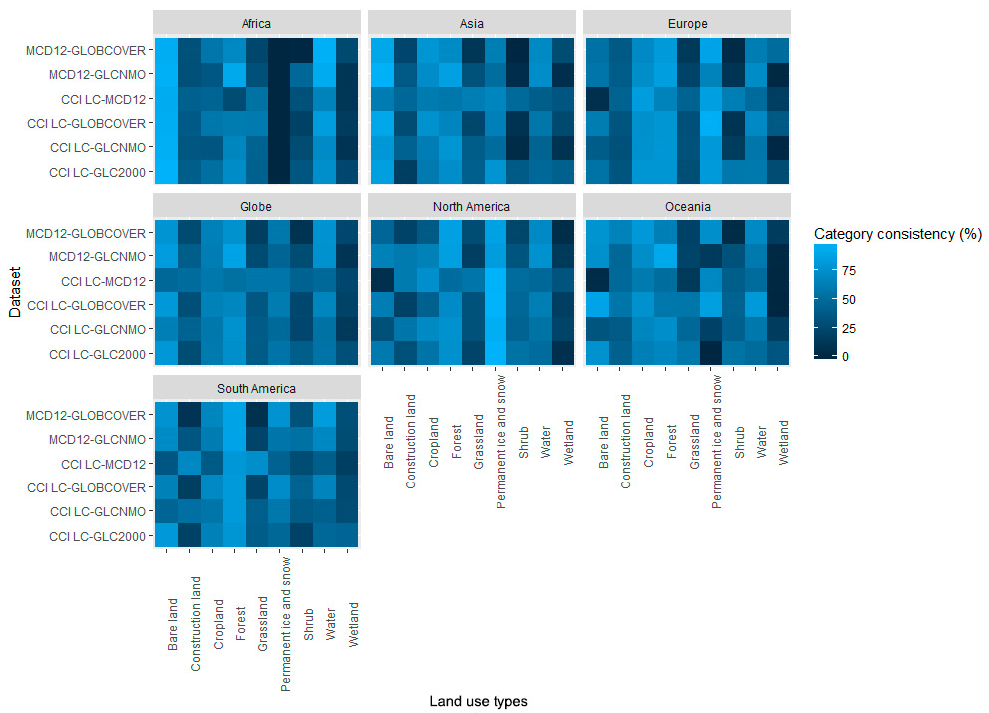
Figure 2. Category consistency at the global and continental scales.